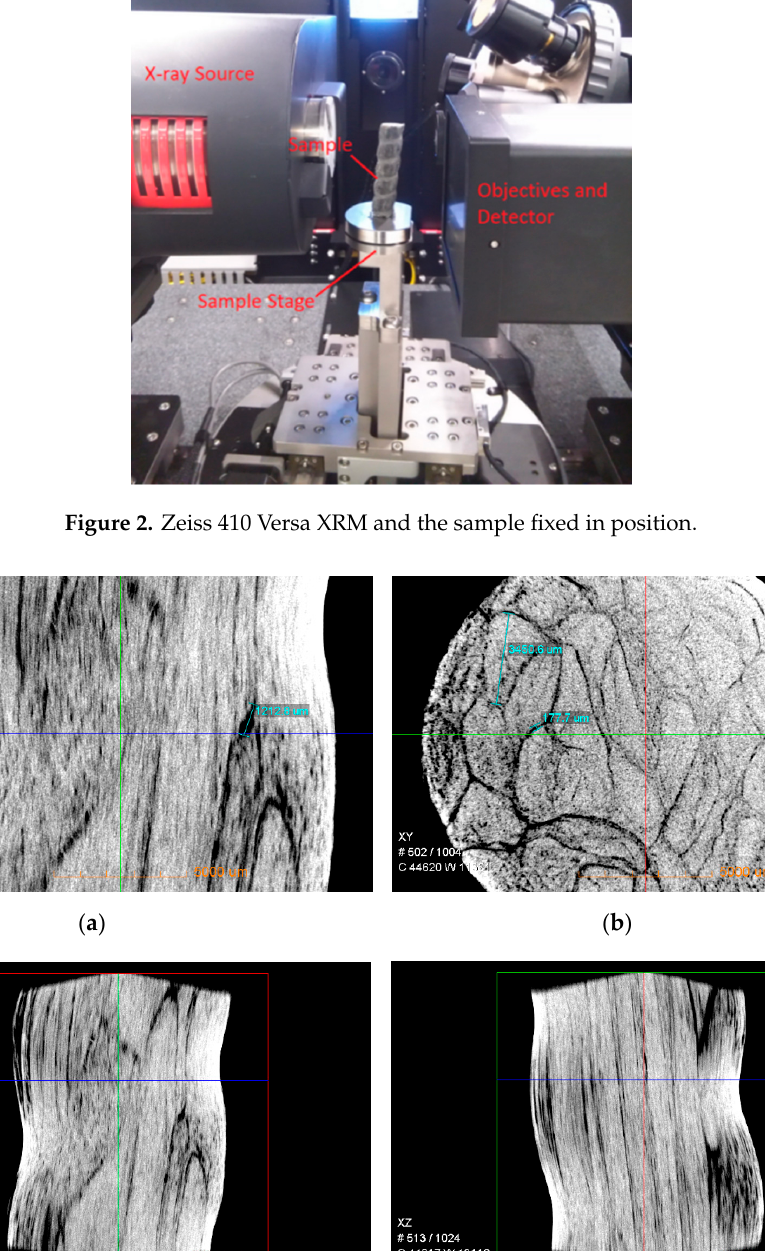
Figure 3. 3D CT images of the internal structure of GFRP bars of: ( a ) YZ-plane; ( b ) XY-plane; ( c ) YZ-plane; and ( d ) XZ-plane .